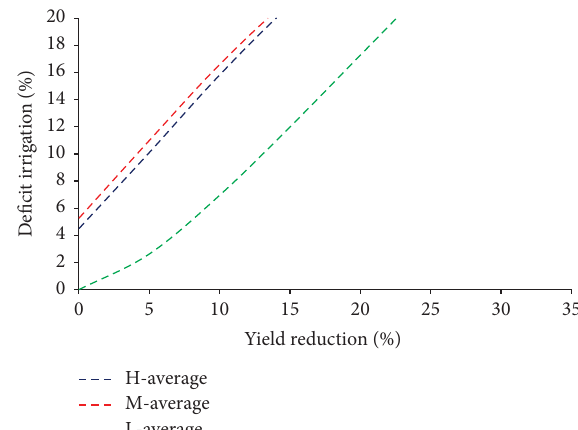
Figure 5: Average deficit irrigation and yield reduction of the eight crops for height, medium, and light soil relative to all crops.